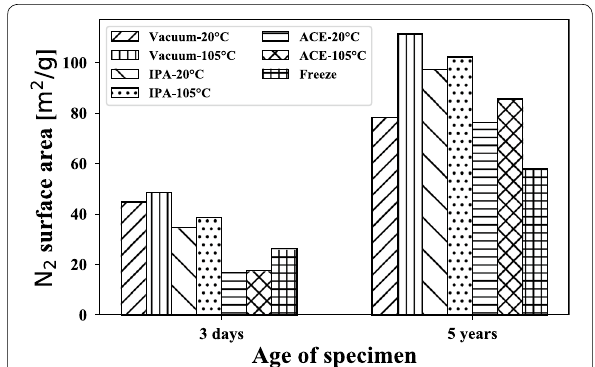
Fig. 11 Comparison of pore size distribution from different techniques. Sorption isotherm data from Maruyama et al. (2014), NMR data from Maruyama et al. (2019). The volume of pores obtained from nitrogen sorption should be read from left Y-axis, while pore volume from water vapor sorption and NMR should be read from right